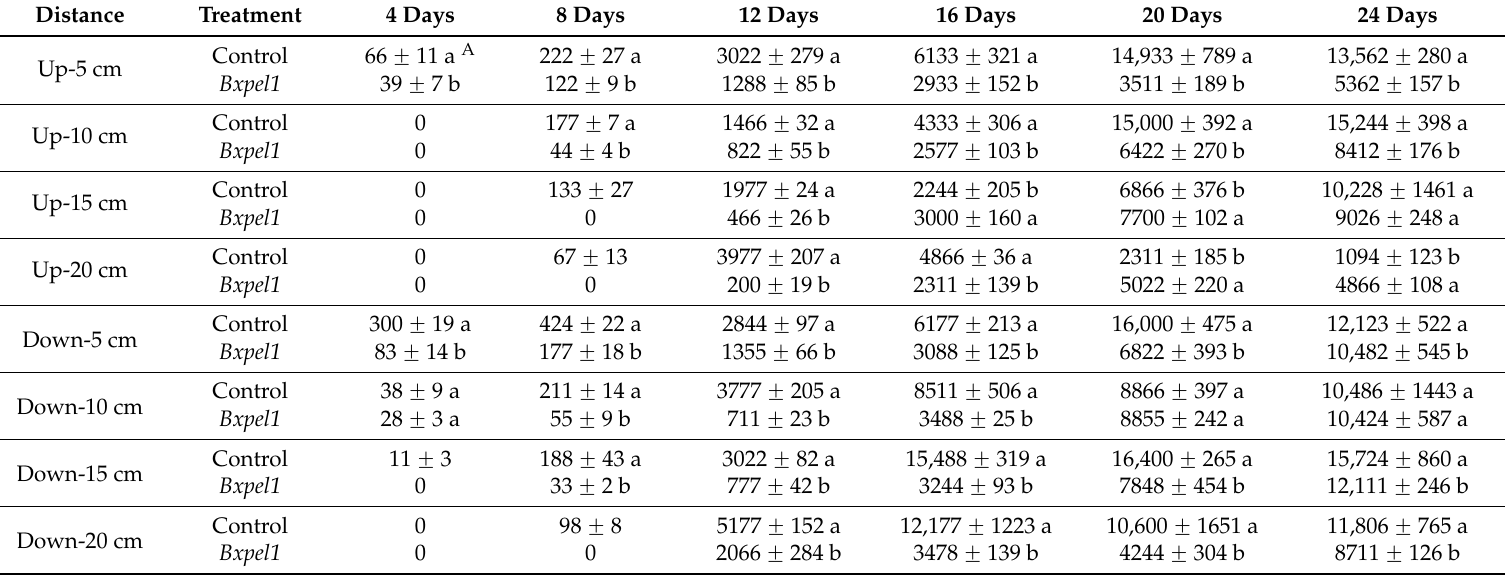
Table 1. Migration and reproduction of B. xylophilus after inoculation into P. thunbergii